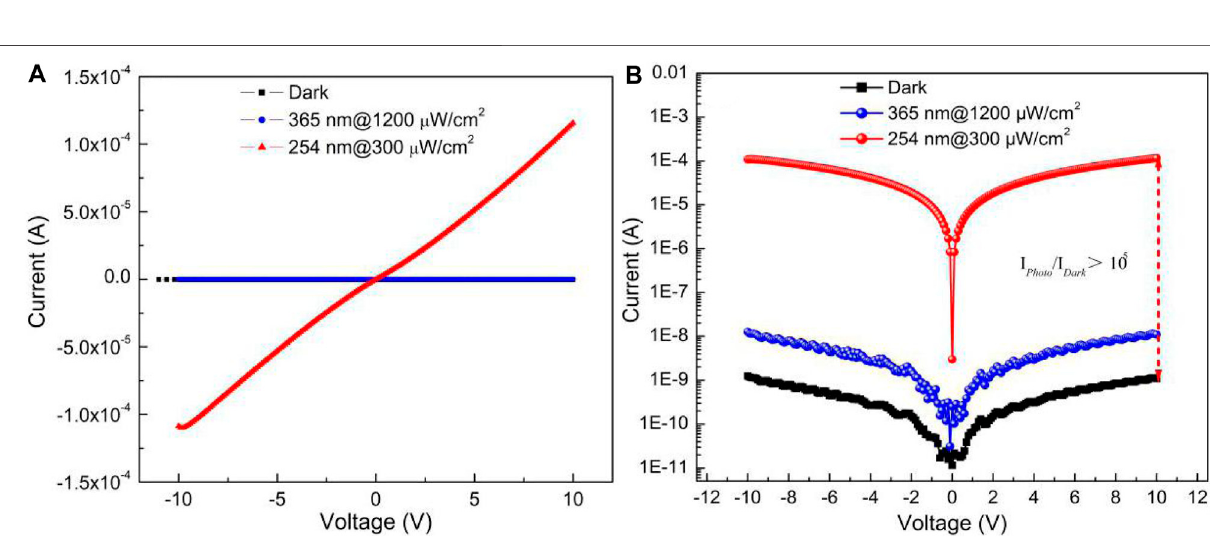
Frontiers in Materials |